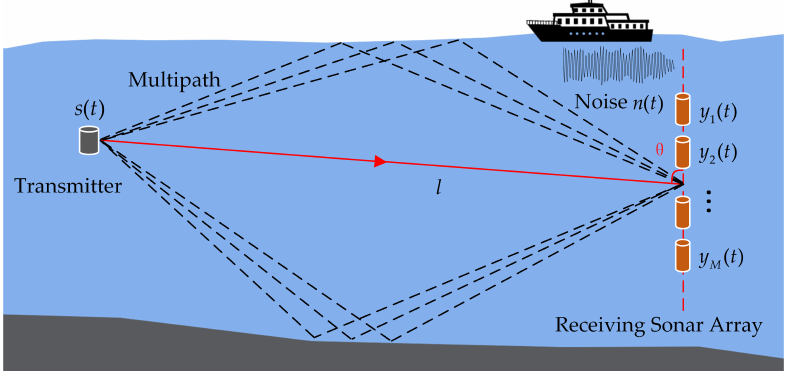
Figure 3. A UWA array transmit–receive structure of a SIMO